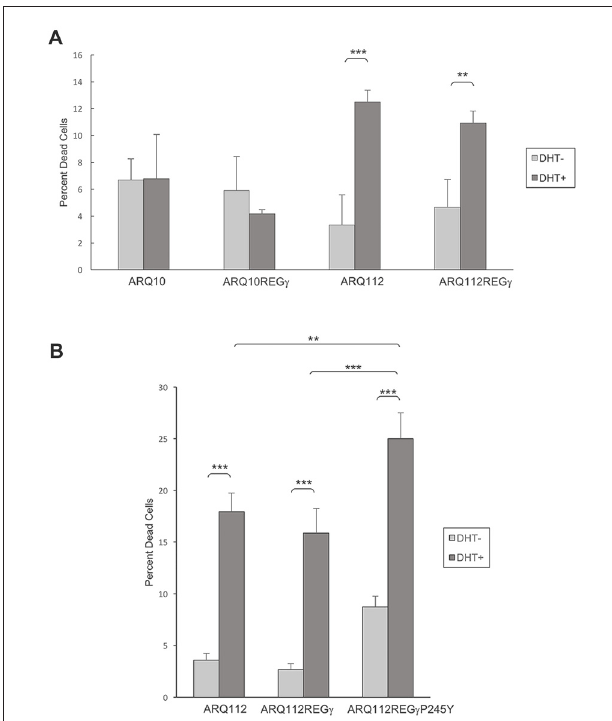
FIGURE 5 | Overexpression of REG γ and mutant REG γ P245Y fail to protect PC12 ARQ112 cells from DHT-dependent death. (A,B) ARQ10 and ARQ112 cells with and without stable expression of REG γ or REG γ P245Y were cultured in the presence or absence of DHT for 12 days. Cells were stained with trypan blue, 200 cells were counted in triplicate, and the percentage of dead cells (trypan blue-positive) was calculated. Data are representative of more than three independent experiments. Statistical analysis was carried out using two-factor ANOVA with post hoc Tukey HSD for individual comparisons. ∗∗ p < 0.01; ∗∗∗ p < 0.001.